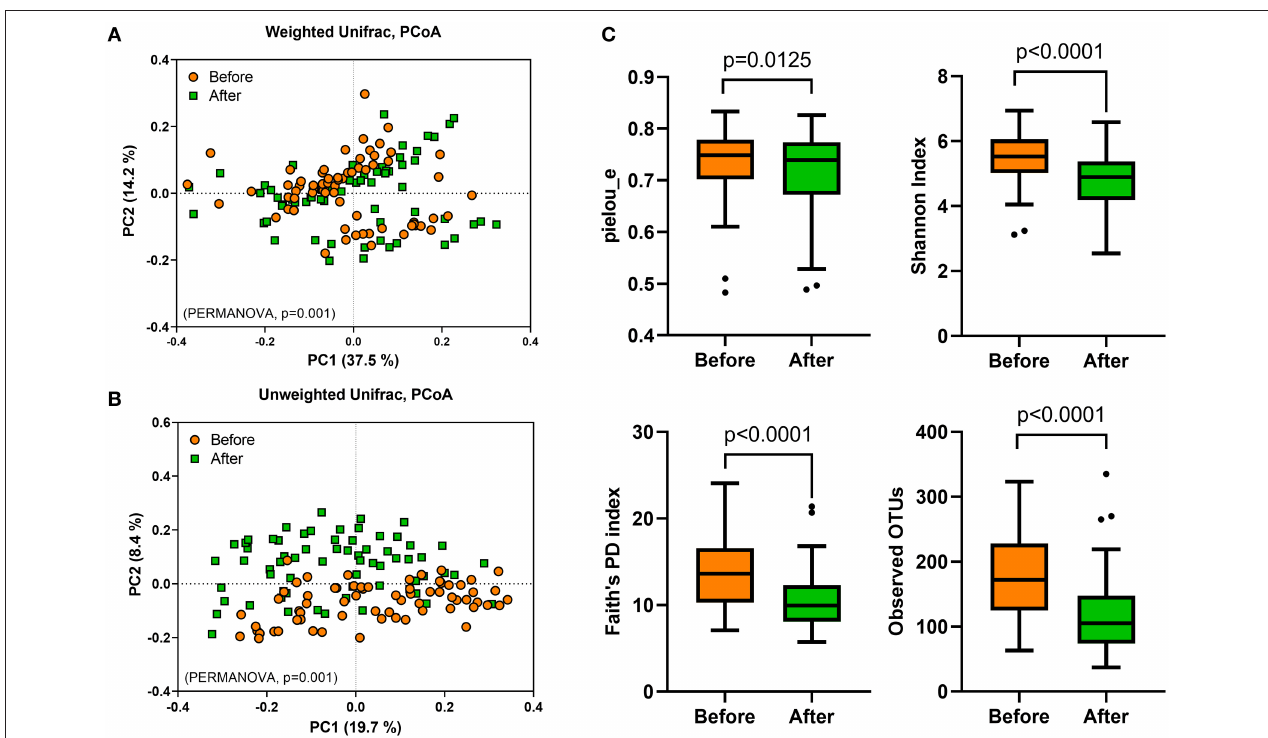
FIGURE 2 | Gut microbial diversity is altered following Saengshik supplementation. The β -diversity of gut microbiota was compared using principal coordinates analysis plot based on (A) weighted and (B) unweighted UniFrac distances. A PERMANOVA test was used to evaluate differences in bacterial diversity between the two time points [before (orange; n = 66) and after (green; n = 66) intervention]. (C) Comparison of α -diversity in gut microbiota between the two time points [before (orange; n = 66) and after (green; n = 66) intervention]. Tukey’s box-and-whisker plots show the median (horizontal line) and interquartile range (IQR) (box), with additional data within 1.5 IQR shown as whiskers. The Pielou’s evenness, Shannon, Faith’s PD, and observed OTU indices of the samples were statistically compared between the two time points using the Wilcoxon rank-sum